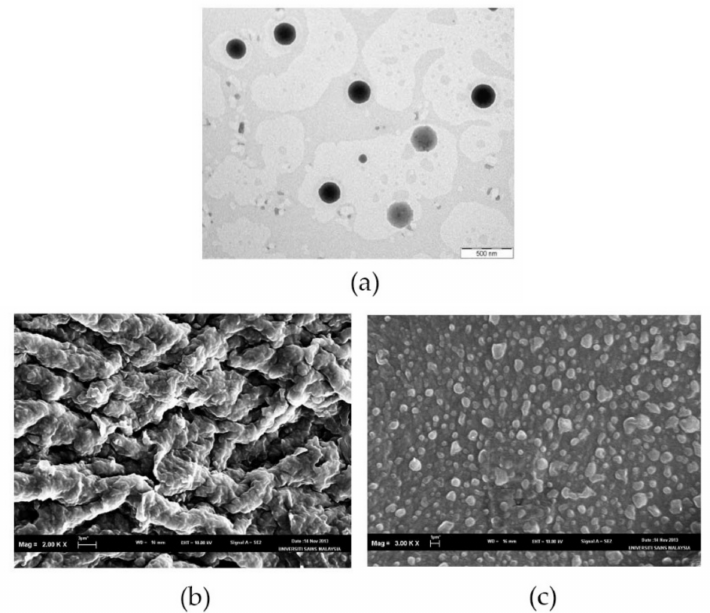
Figure 7. ( a ) TEM image of LPV-NLC-7 before freeze-drying; ( b ) SEM image of LPV-NLC-7 after freeze drying, and ( c ) SEM image of LPV-NLC-7-Tres after freeze